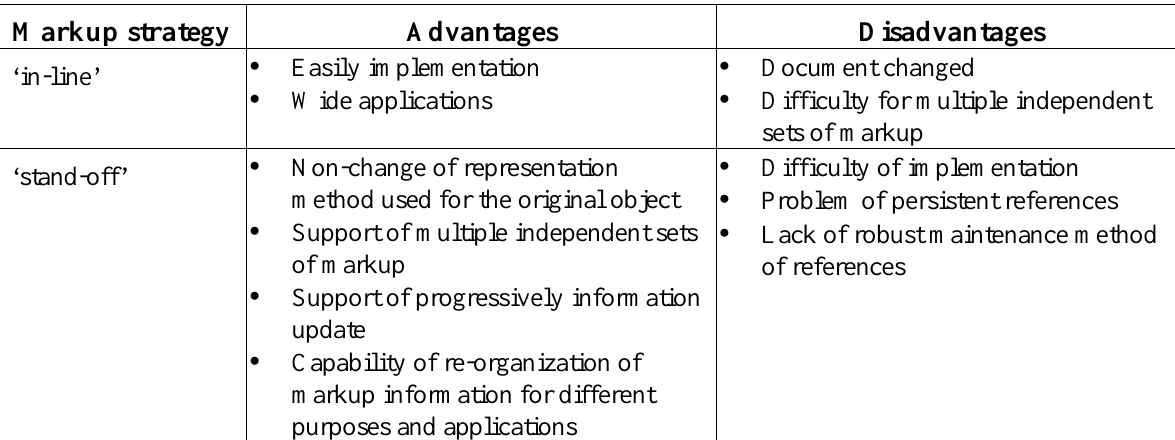
Table 2. Advantages and disadvantages of markup